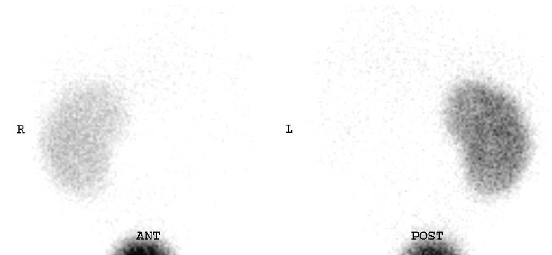
Figure 2. Dimercaptosuccinic acid scintigraphy indicates non- visualized functional cortical uptake in the left kidney on day 13 postpartum.